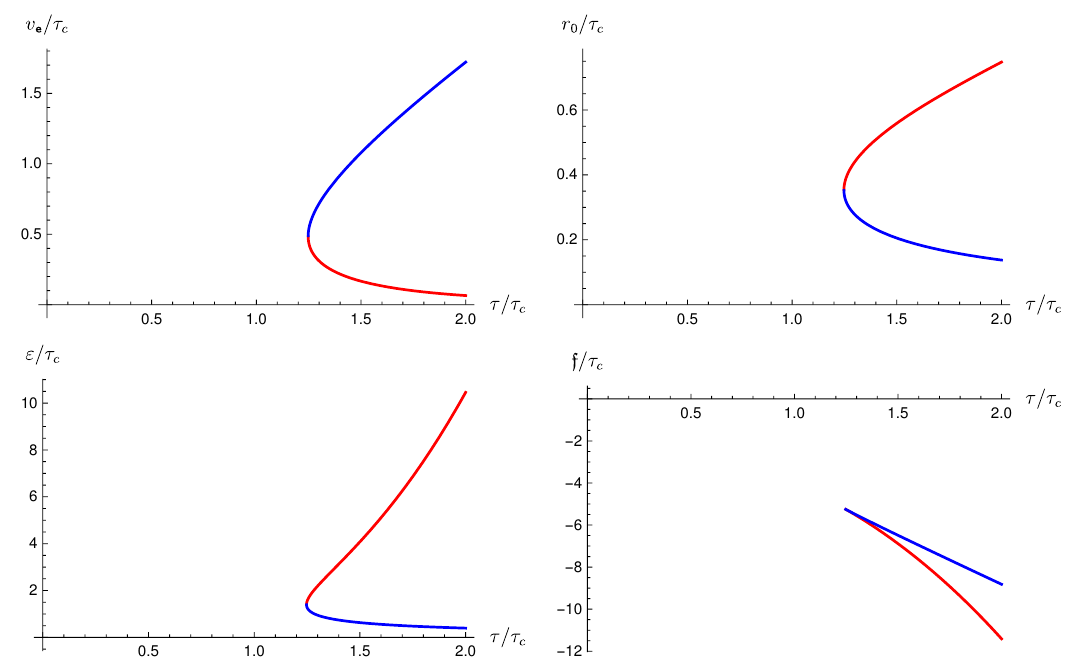
Figure 5 . Plot of the solutions of (6.24) for (cid:26) = 1 : 1 (cid:26) c , together with the corresponding energy " and Helmholtz free energy f densities.